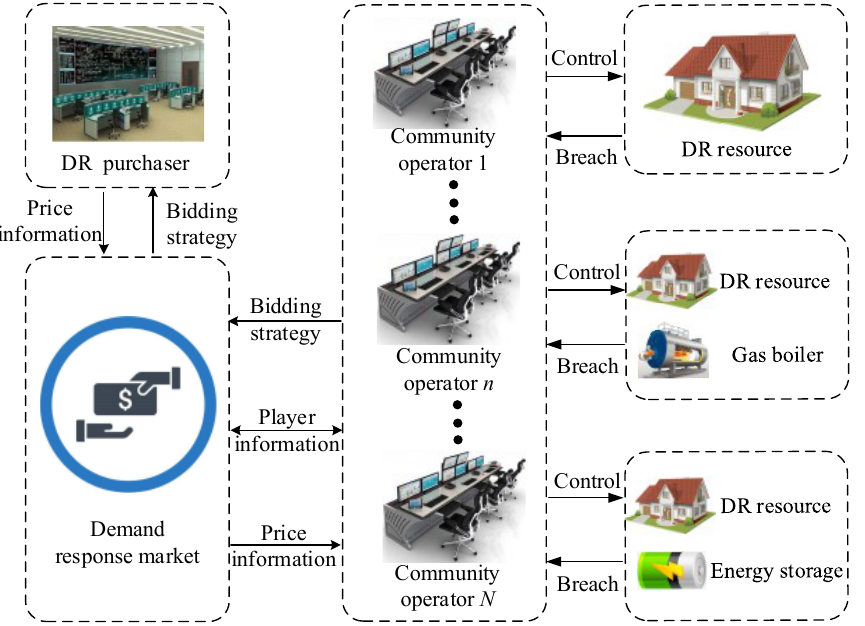
Figure 1. Framework of demand response (DR) market with community operator considering DR resource’s